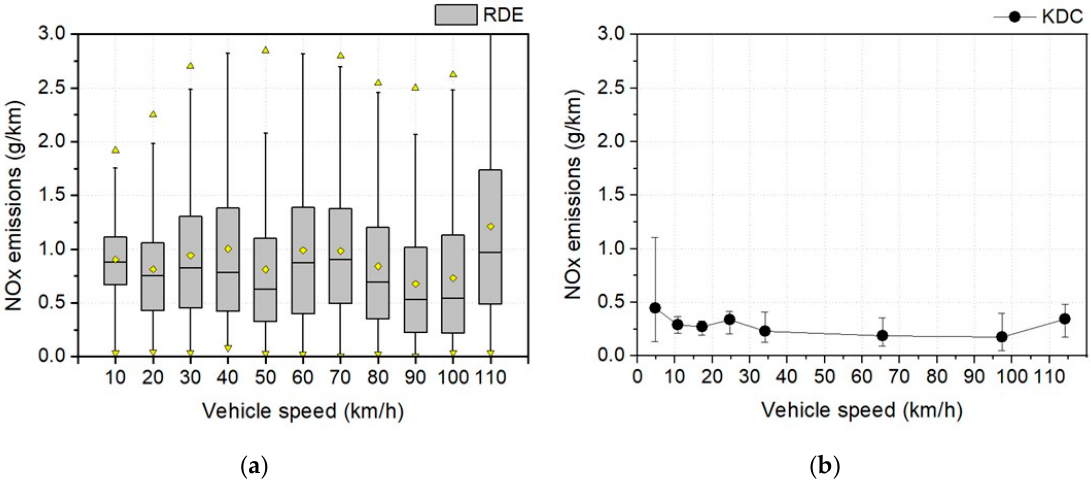
Figure 6. Results of NOx emissions by vehicle speed under the Real Driving Emissions (RDE) and Korea Driving Cycle (KDC) tests. ( a ) The 1-km section analysis for RDE tests and ( b ) averaged emissions in each sub-cycle of KDC.